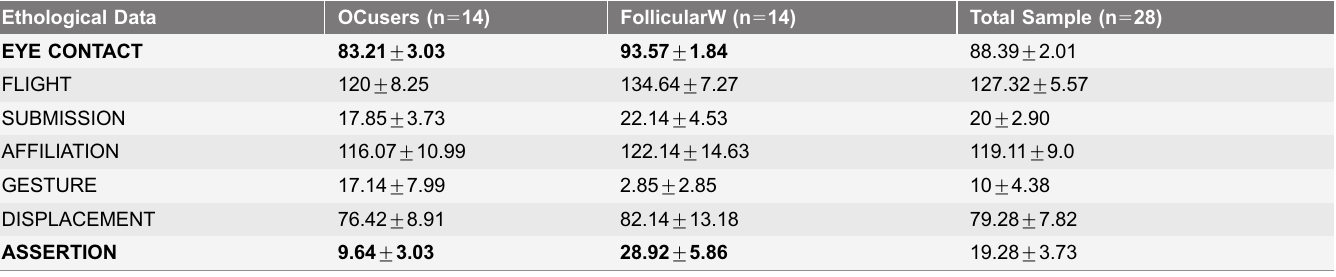
Table 2. Total sum of the behavioral patterns’ values of each behavioral category (% mean ¡ SEM) displayed during speech (ECSI). Ethological